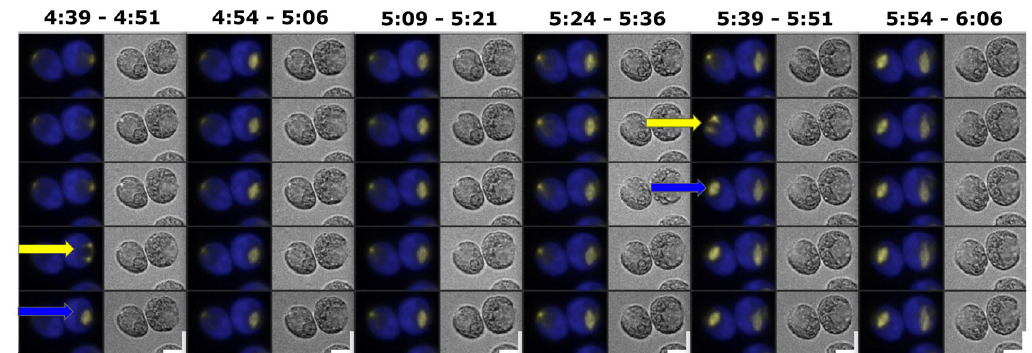
Fig 9. Live cell time-lapse of cdc27-6;EB1 : NG-TG cells. Live cell time-lapse acquired with microscopy method 1 (see Methods section). Each cell has a brightfield image (right), and a composite of EB1-NG signal in yellow and chloroplast autofluorescence signal in blue (left). Yellow arrows: spindle pole separation. Blue arrows: new spindle formation. Time indicated on top of each strip is hours and minutes after beginning of time-lapse. The indicated time corresponds to the top cell in each strip. Each subsequent cell going down is from an image captured every 3 minutes.